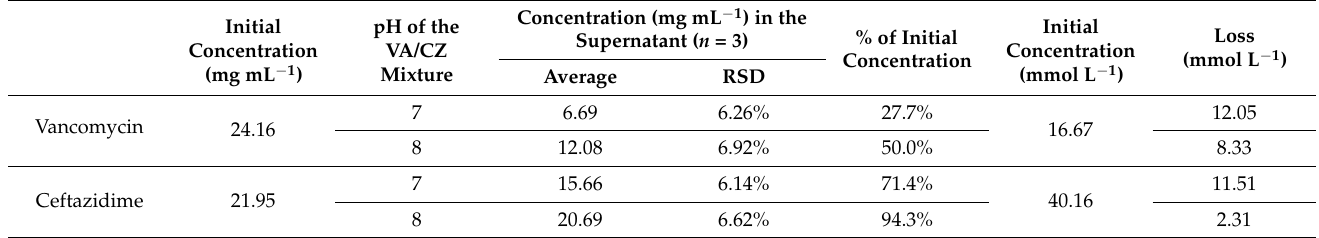
Table 1. Ceftazidime (CZ) and vancomycin (VA) concentrations in the supernatant after centrifugation of the solution mixture, as a function of the mixture pH. RSD: relative standard